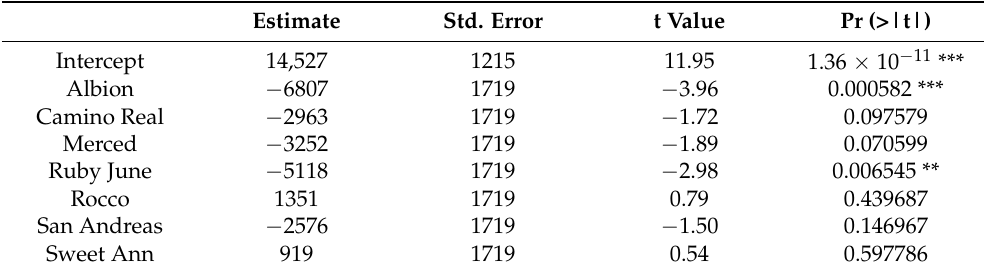
Table 2. Estimated average yield (kg ha − 1 ) from strawberry cultivars produced in the open-field with ‘Chandler’ cultivar as the base